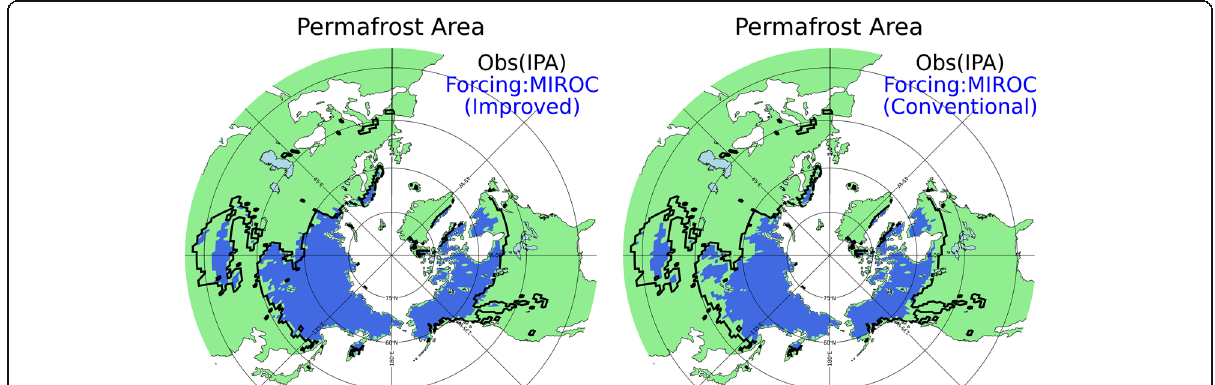
Fig. 2 Permafrost area of the historical model simulation (blue) and observation (outlined in black). The historical simulation was performed with the MIROC atmospheric forcing. The permafrost area is determined using the soil temperature for the year 2000. The observed permafrost area is from Brown et al. (1998)